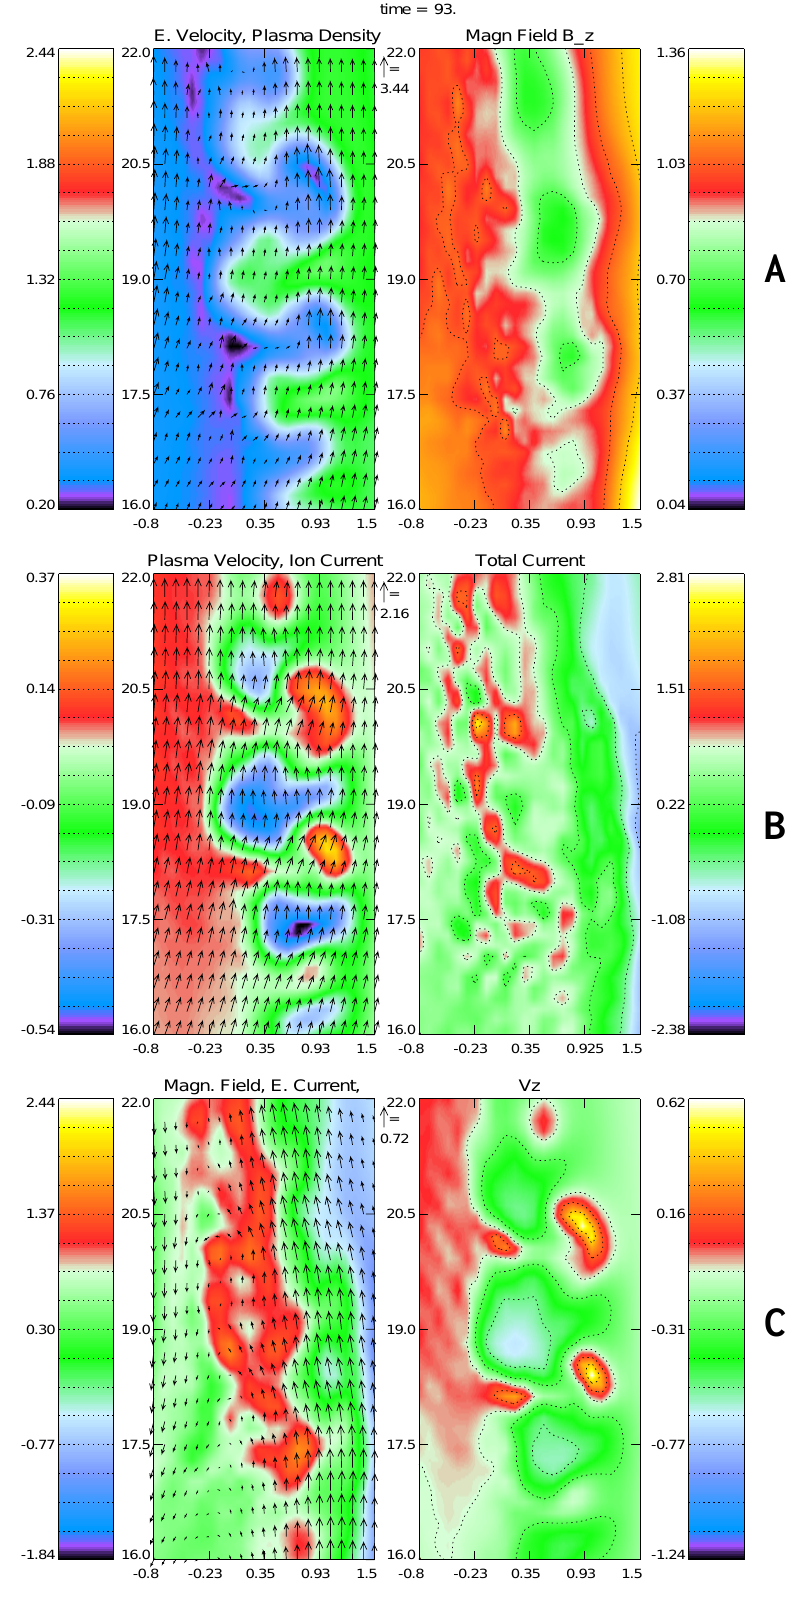
Fig. 11. (A) is a magnified domain of Fig. 10A. (B) shows plasma velocity vectors (arrows), and ion current (color code) on left and total current on right. (C) depicts magnetic field vectors (arrows) and electron current (color code) on left, and z -component of the plasma velocity on